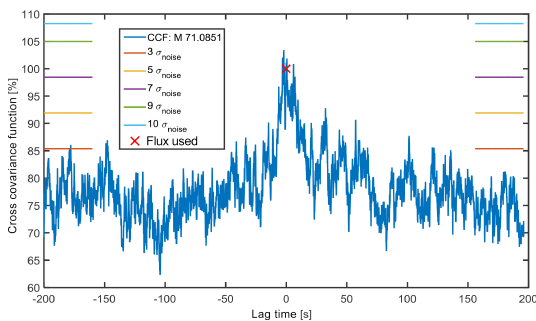
Figure A9. Averaged absolute CCF of mass 71.0851 (could not be identified), which fulfilled the 7 σ noise . The flux used is well 9